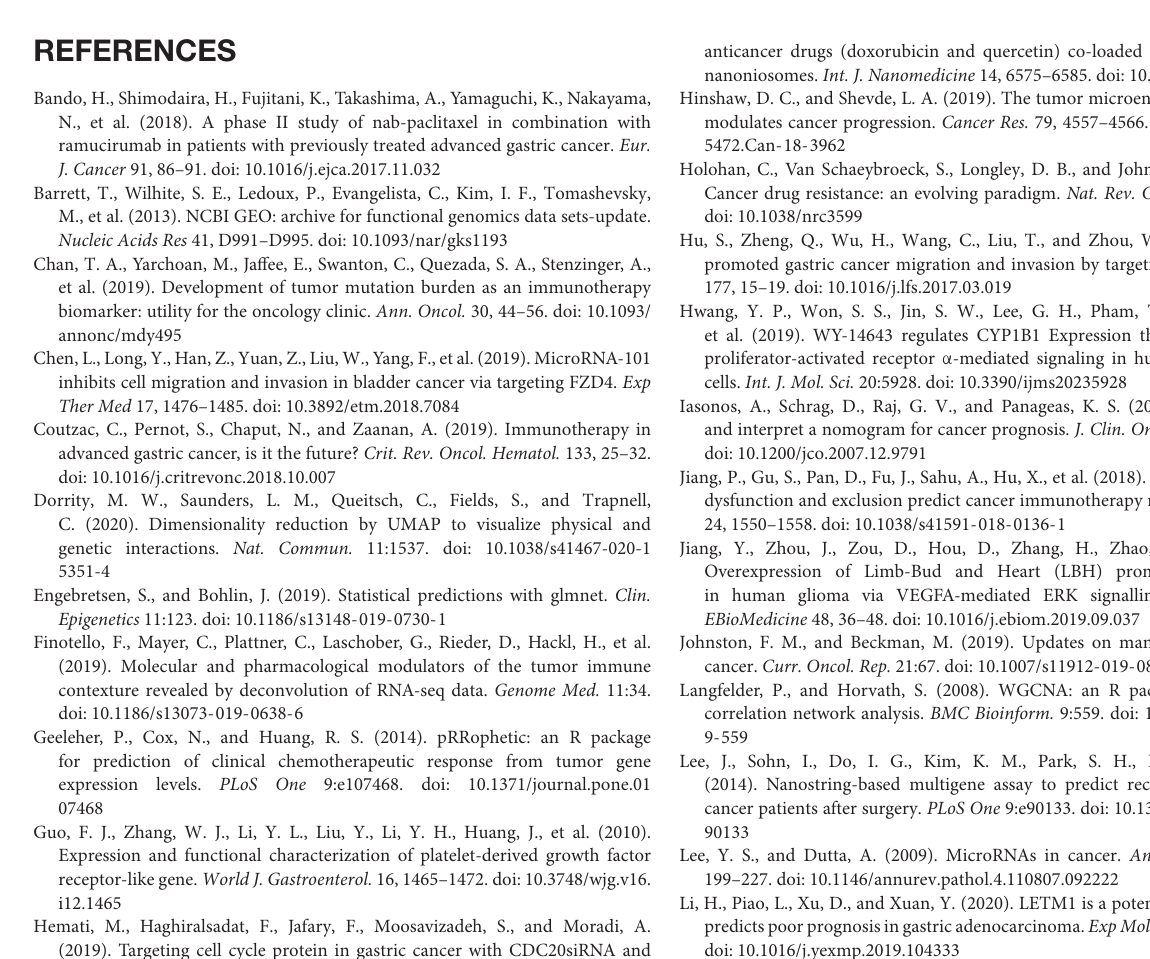
Supplementary Figure 1 | (A) The relationships between different gene modules. (B) Relative change in area under the cumulative distribution function (CDF) curve for k = 2 to 6. (C) Tracking plot for k = 2 to